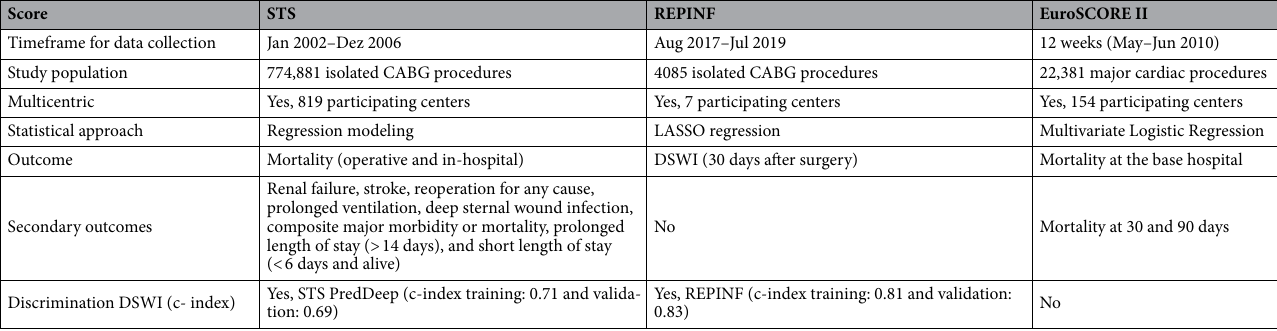
Table 4. Comparison of baseline characteristics of STS, REPINF and EuroSCORE II models, São Paulo, Brazil,